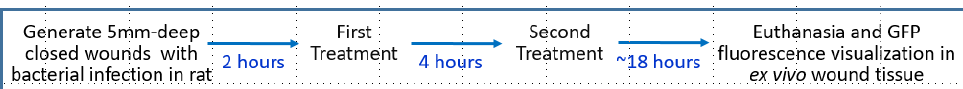
Figure 5. Timeline of wounding, treatments and GFP fluorescence visualization.